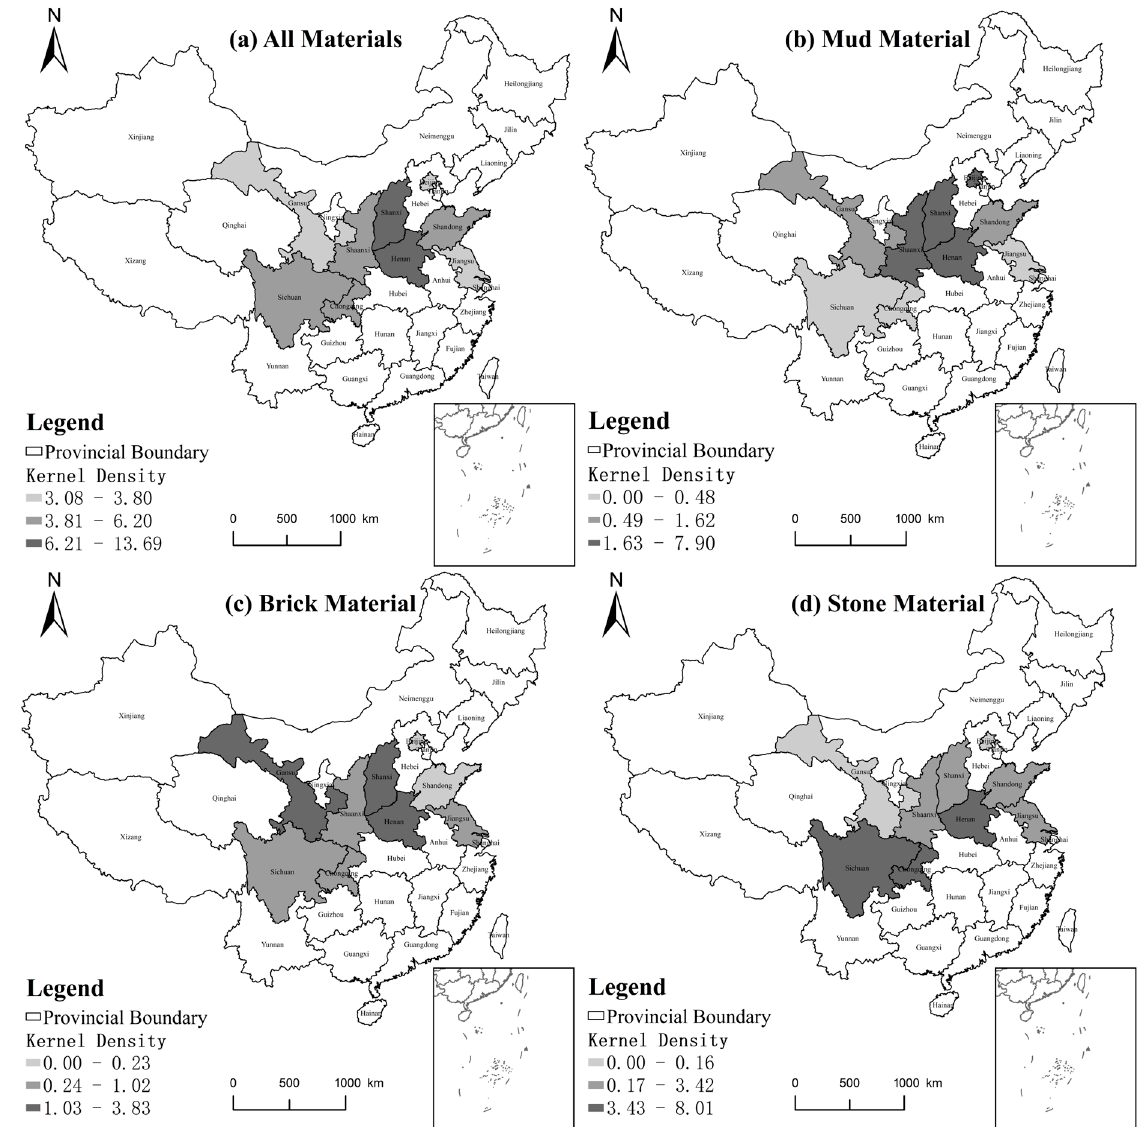
Figure 4. Overall kernel density distribution map of the types of relic sites in nine provinces.